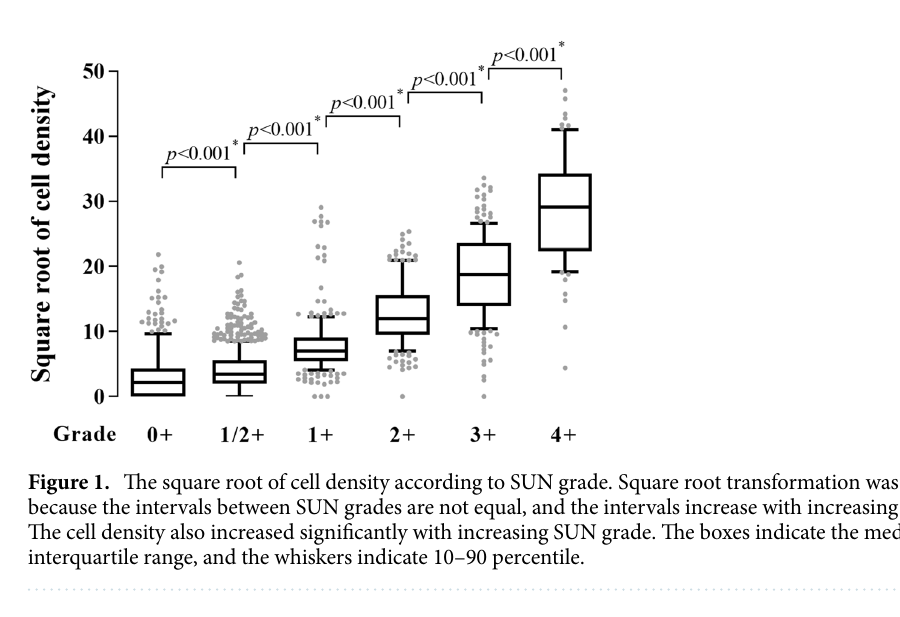
Table 1. Comparison of cell density and cell size in anterior segment SD-OCT images in each grade. IQR interquartile range. *Continuous high reflective pixel area in the anterior chamber. † p value of Wilcoxon signed- rank test adjusted by Bonferroni method.